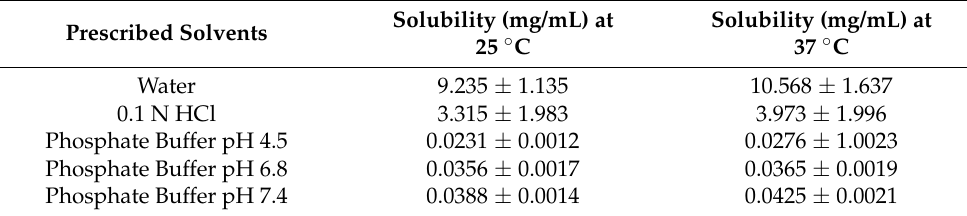
Table 2. Metronidazole solubility studies conducted at different pH media (mean ± SD).